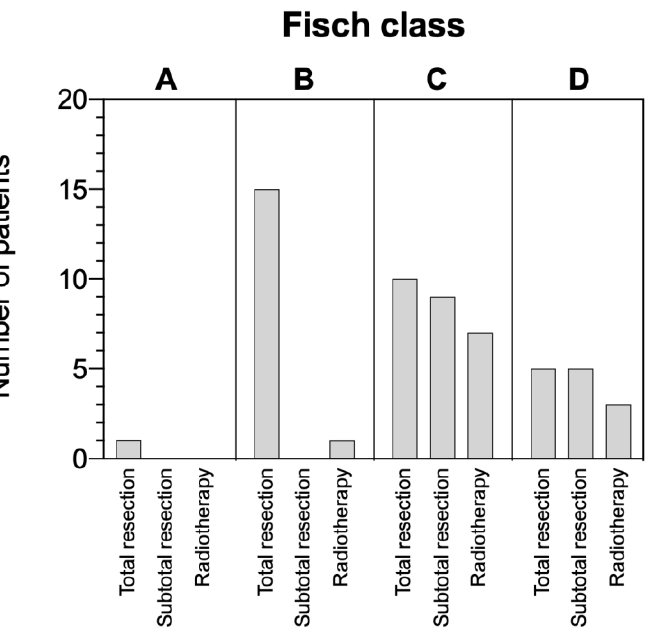
Figure 3. Frequency distribution of different primary therapies in all observed patients. Column A represents patients with a paraganglioma classified as Fisch A TBPs. Respectively, column B represents Fisch B, column C represents Fisch C and column D represents Fisch D TBPs. Radiotherapy includes conventional radiotherapy or gamma-knife radiosurgery.